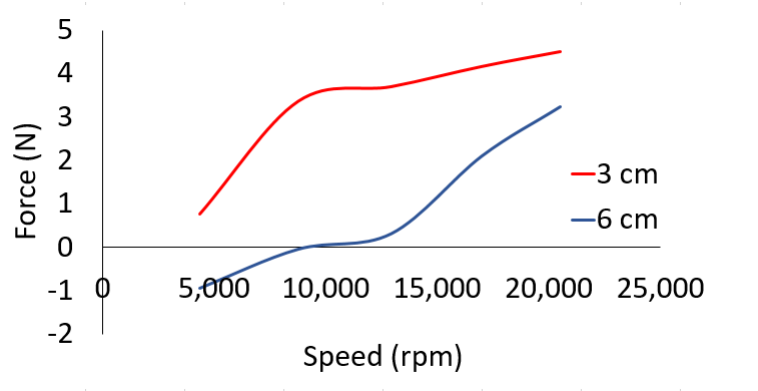
Figure 18. Contact force variation for 3 cm and 6 cm opening of the suction chamber.